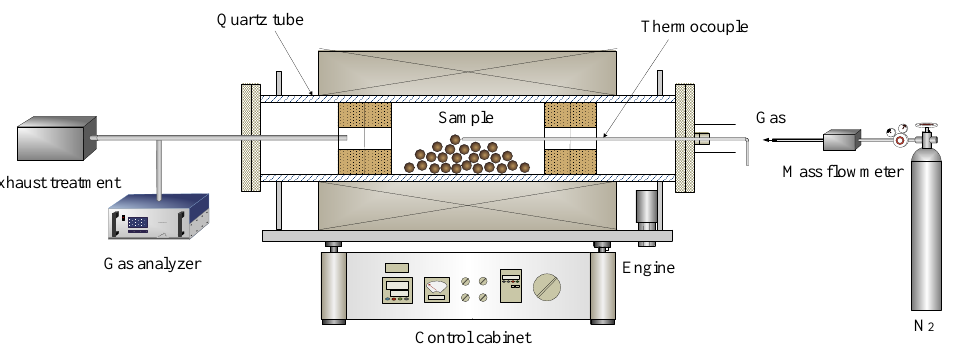
Figure 3. Schematic diagram of a laboratory-scale simulated rotary kiln.